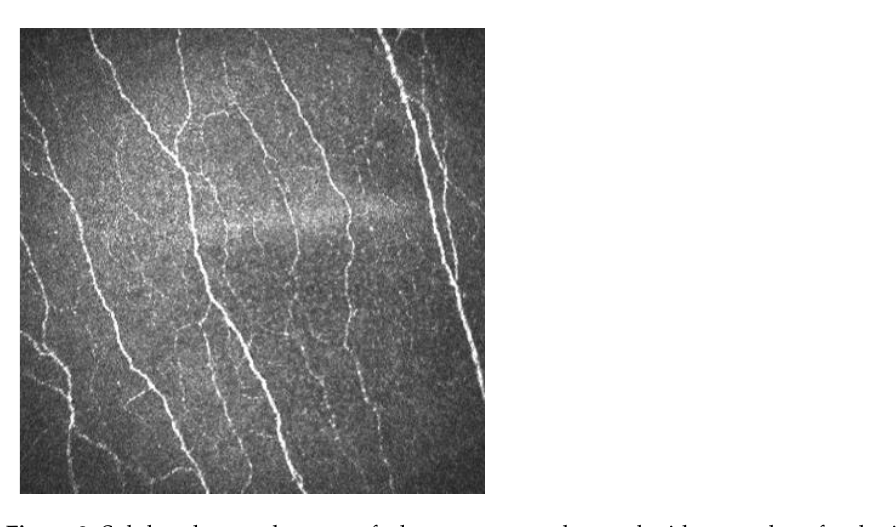
Figure 2. Sub-basal corneal nerves of a human cornea observed with corneal confocal microscopy, using the HRT II.